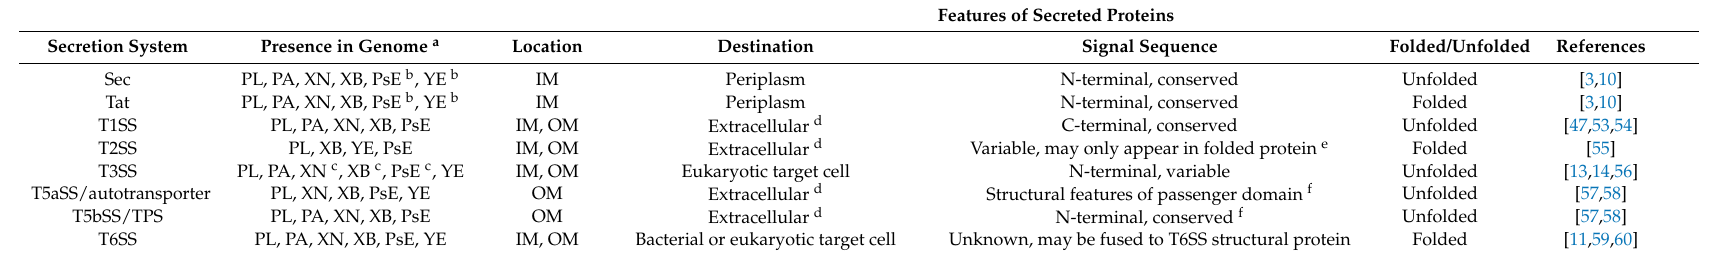
Table 1. Properties of bacterial secretion systems and distribution in